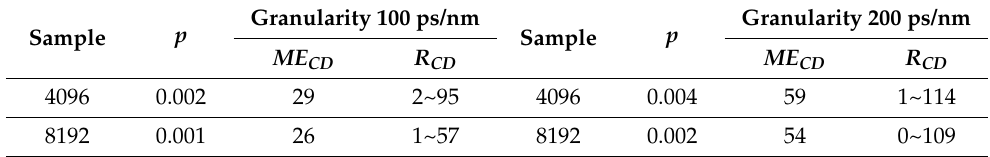
Table 2. Performance of the CD estimation.